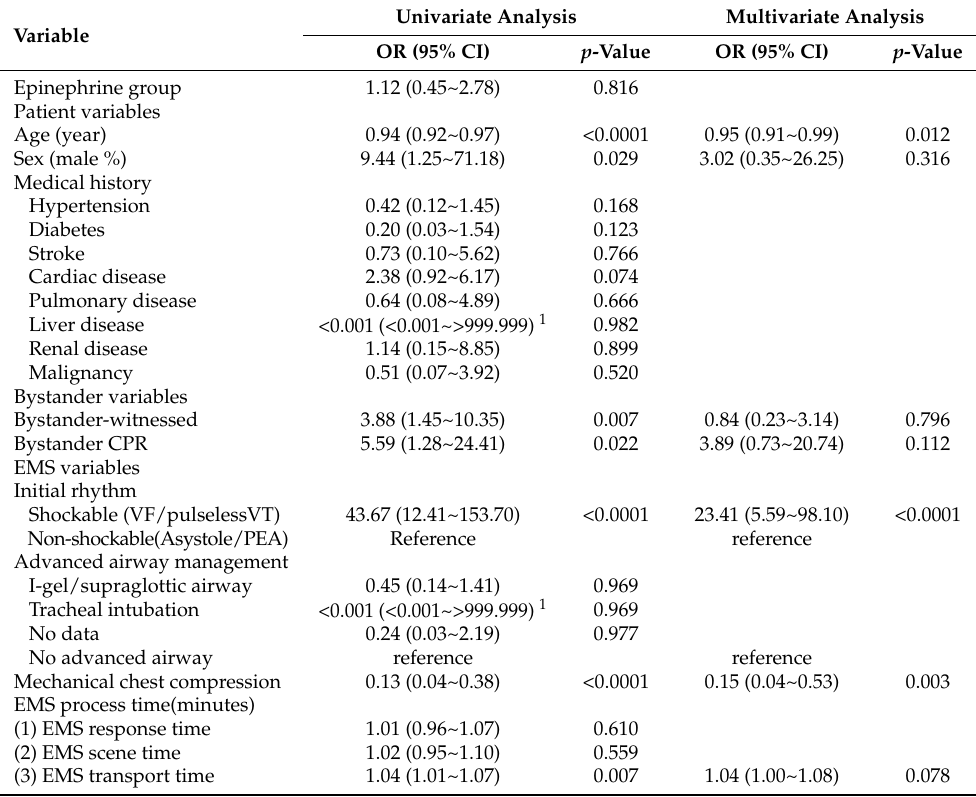
Table 5. The prognostic factors affecting favorable neurological outcomes in prehospital epinephrine administration by EMS